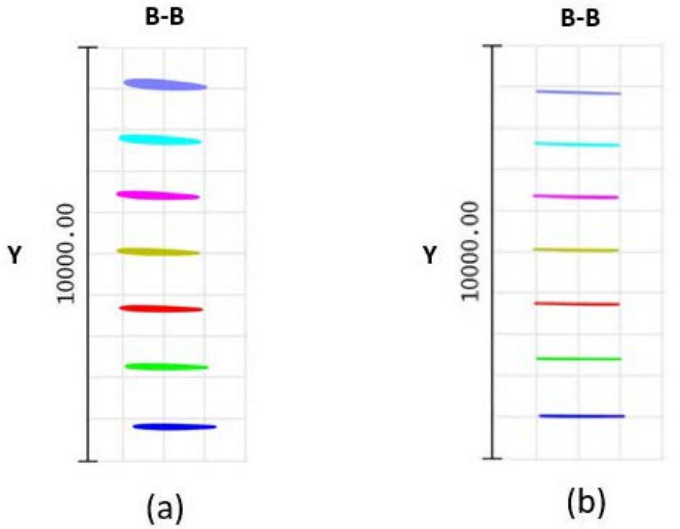
Figure 5. ( a ) Spot diagram before optimization; ( b ) spot diagram after